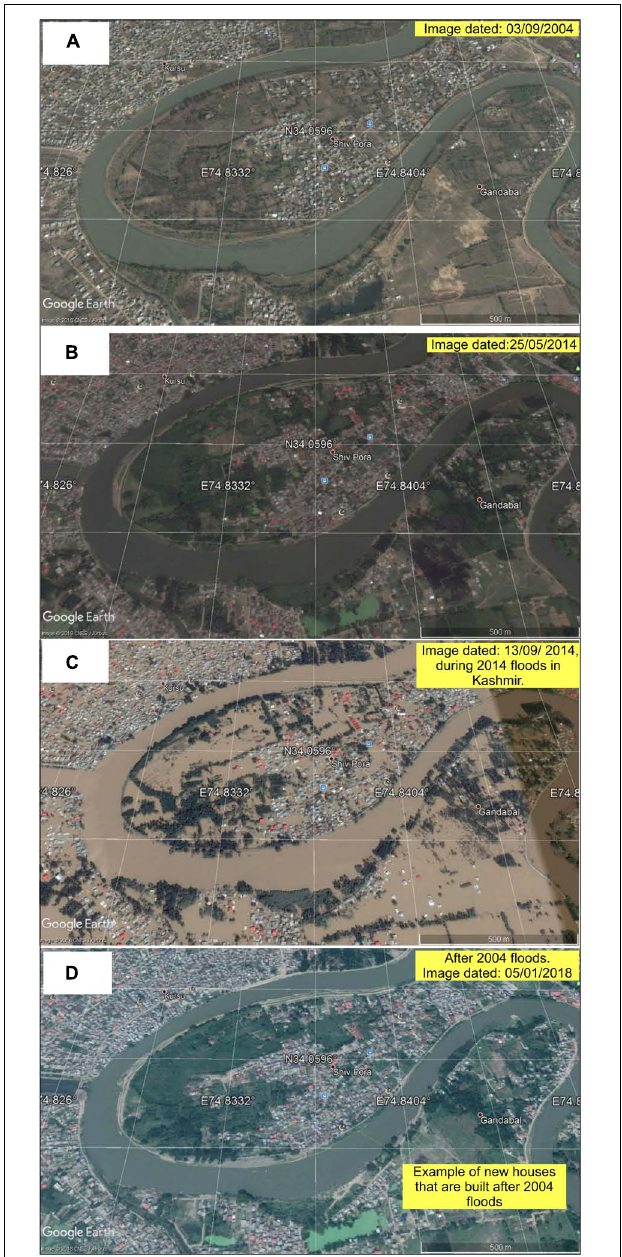
FIGURE 5 | The historical Google satellite images are shown and the urbanization is highlighted (A–D) . The region which was completely submerged during the September 2014 floods are now reoccupied (C,D) . Such practices are a routine in Jammu and Kashmir. All satellite images are obtained on 20th July 2018 from Google Earth that uses images from CNES/Airbus.